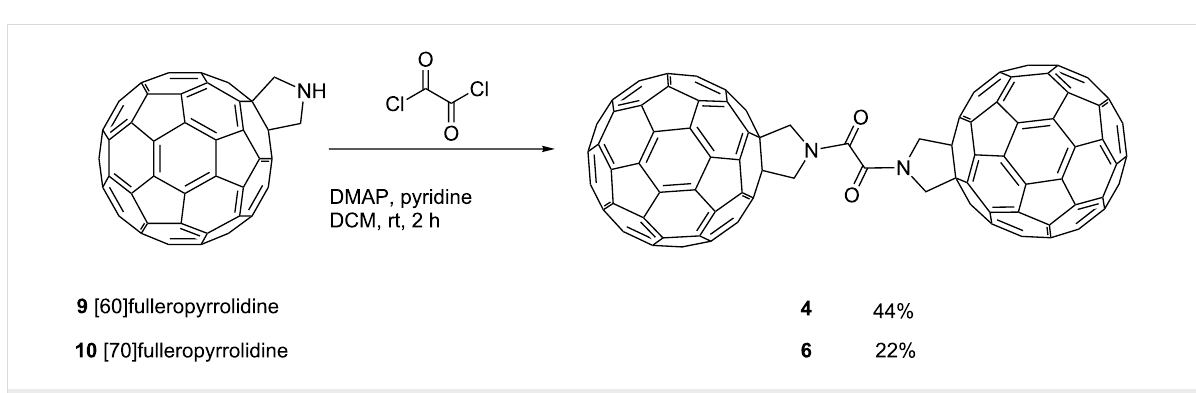
similar to those of terephthalate bridged triads 1 – 3 , including good solubility in organic solvents such as CS 2 and o -dichlorobenzene (ODCB). To link the C 60 and C 70 fulleropyrrolidines within asymmetric triads with an oxalate spacer we attempted a similar stepwise approach as reported for compounds 1 – 3 (Scheme